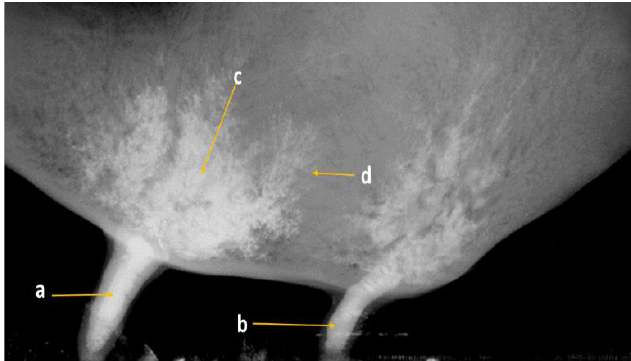
Figure 9. Radiographic image of the left halve in non- lactating udder (20 mL of barium sulfate contrast media) shows: (a) Teat canal of fore quarter (b) Teat canal of hind quarter, (c) Lactiferous sinus (d) Alveolus